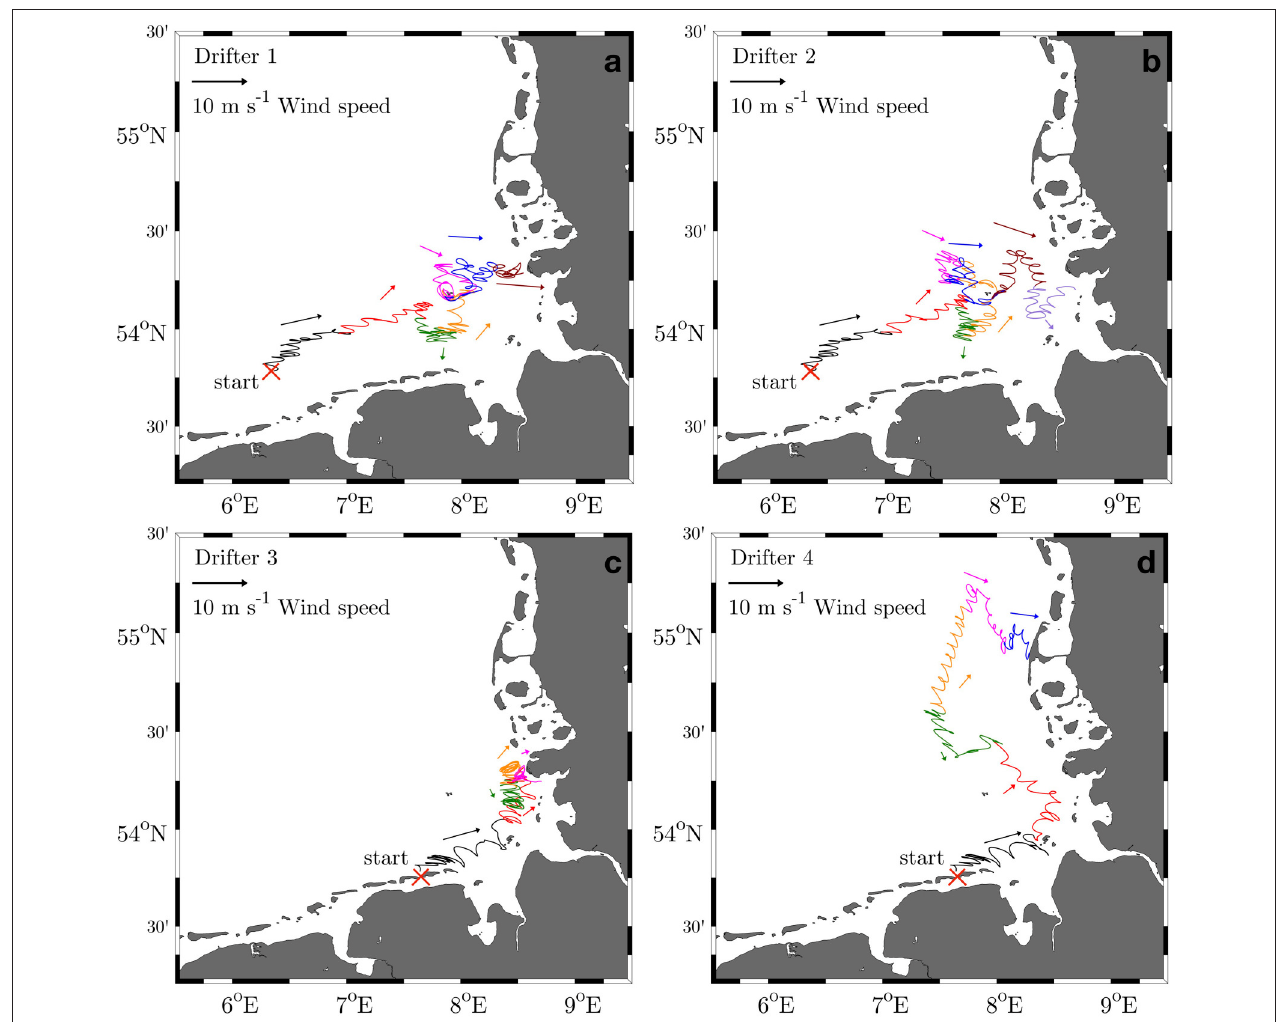
FIGURE 6 | Trajectories of 4 drifters deployed in March 2017. (a–d) The release location is indicated by a red cross for every trajectory. The trajectories were subdivided into 5-day segments, which are indicated by different colors. The corresponding colored arrows show the mean prevailing wind directions for the associated 5-day segments.